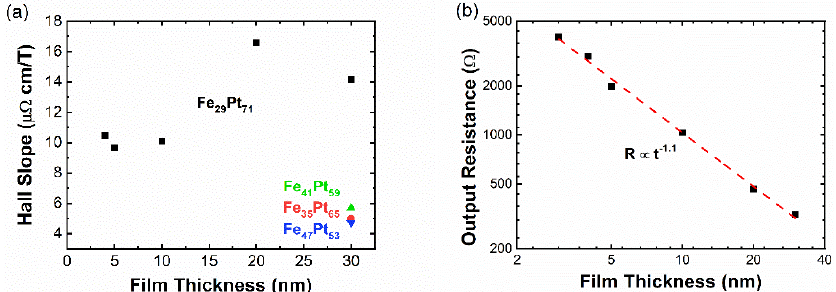
Figure 1. ( a ) Hall slopes versus film thickness and Fe concentration x. ( b ) Output resistance of Fe 29 Pt 71 Hall-bar samples with various film thicknesses. The red dashed line is the linear fitting line in the log–log plot, which gives 𝑅 ~ 𝑡 −1.1 .